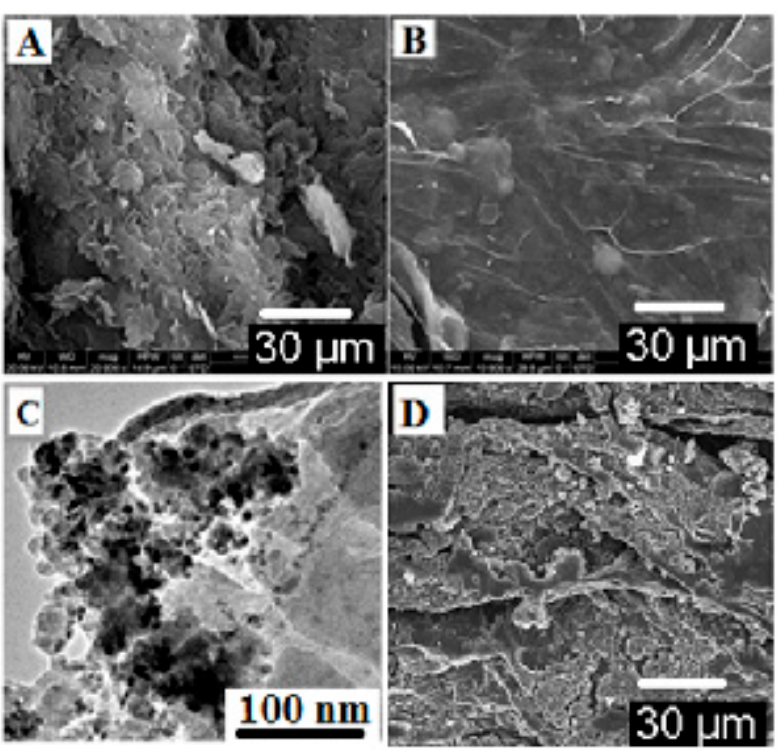
Figure 2. FESEM images show the surface morphology of ( A ) nascent graphene oxide and ( B ) GO/CdS; ( C ) TEM image of GO/CdS and ( D ) FESEM image of GO/CdS after Hg(II) sorption cycle. Utilizing XPS data, we investigated the GO/CdS composite’s surface components (Figure 3A). The data presented in Table 1 provide the binding energies with percent composition for C and O of the GO sheets and Cd and S of the deposited CdS of GO/CdS. Two main peaks were observed for GO; the peak at 284.6 eV was assignable to the sp 2 -carbon species, while the peak at higher binding energies (285–288 eV) was ascribed to oxygenated carbon species, such as hydroxyl and carboxyl groups (Figure 3B). The binding energies of Cd 3d 5/2 were found at 405.5–412.2 eV (Figure 3D), suggesting that cadmium was in the Cd 2+ state. The S 2p 3/2 peaks were observed at 161.1–163.1 eV (Figure 3E), in agreement with the expectation that sulfur existed as the sulfide species (S 2 − ). These observations take into account the structural composition of the prepared sorbent material.